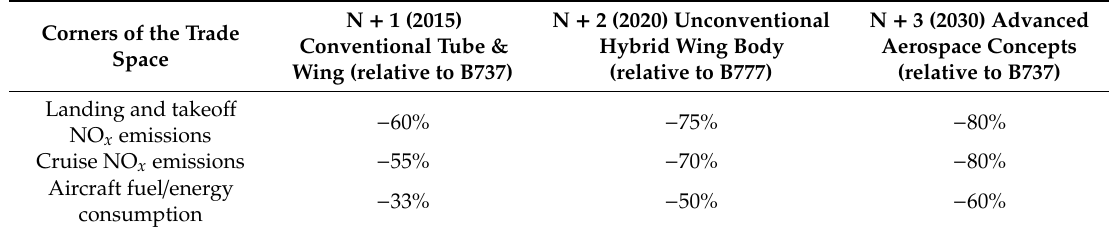
Table 1. National Aeronautics and Space Administration (NASA)’s goals for future-generation subsonic aircraft